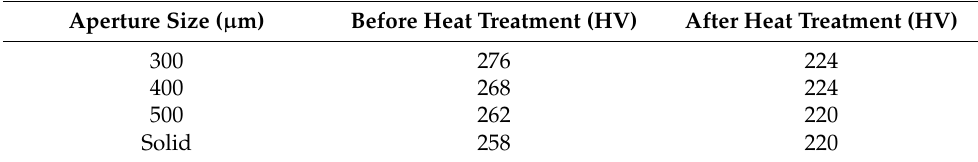
Table 4. Hardness change before and after heat treatment. Aperture Size ( µ